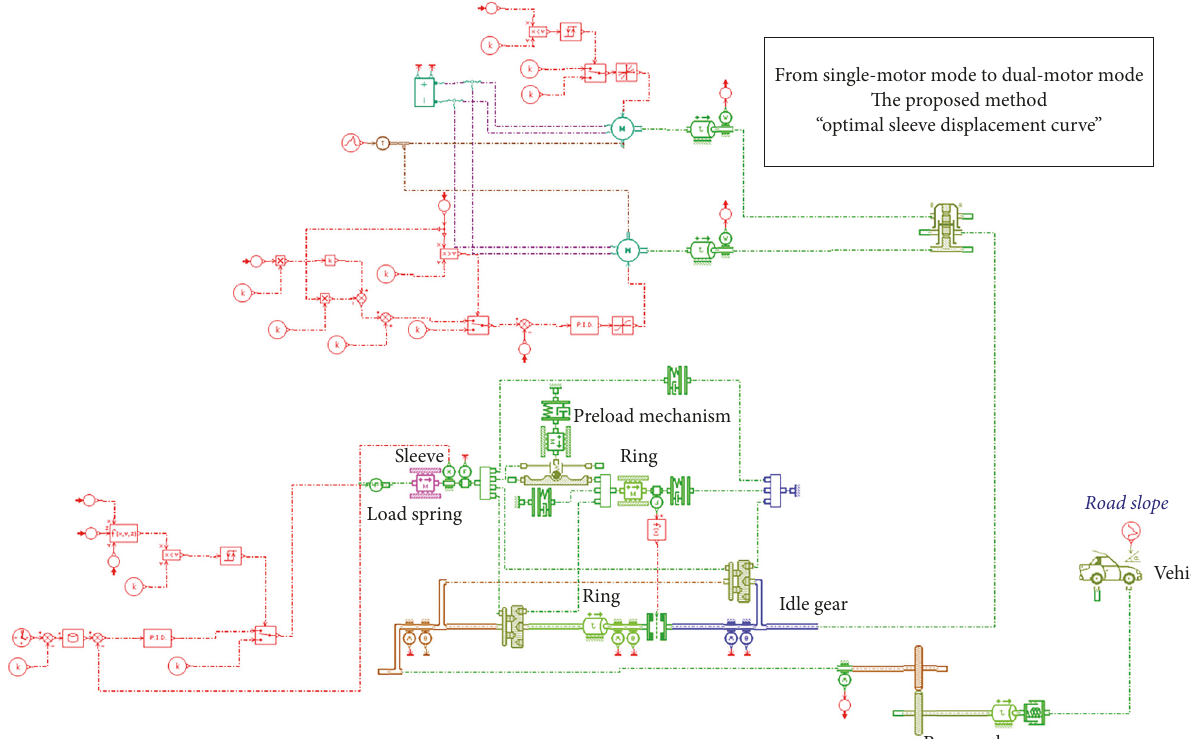
Figure 14: The simulation architecture diagram of the proposed method.